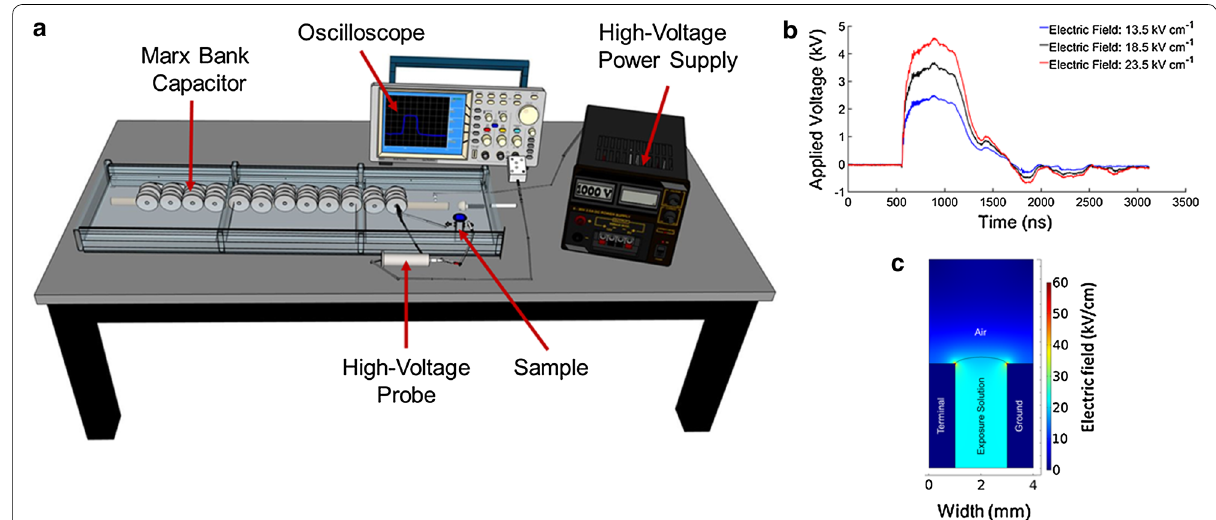
Fig. 1 nsPEF exposure characterization. A schematic of the Marx bank capacitor system used to deliver the 600-ns PEF is provided ( a ). Representative oscilloscope traces of the applied voltages used to deliver an E-field amplitude of 13.5 (blue), 18.5 (black) or 23.5 (red) kV cm − 1 ( b ) are shown. COMSOL Multiphysics ® software was used to model the predicted E-field throughout the electroporation cuvette (both the x and y axis are equal in scale) ( c